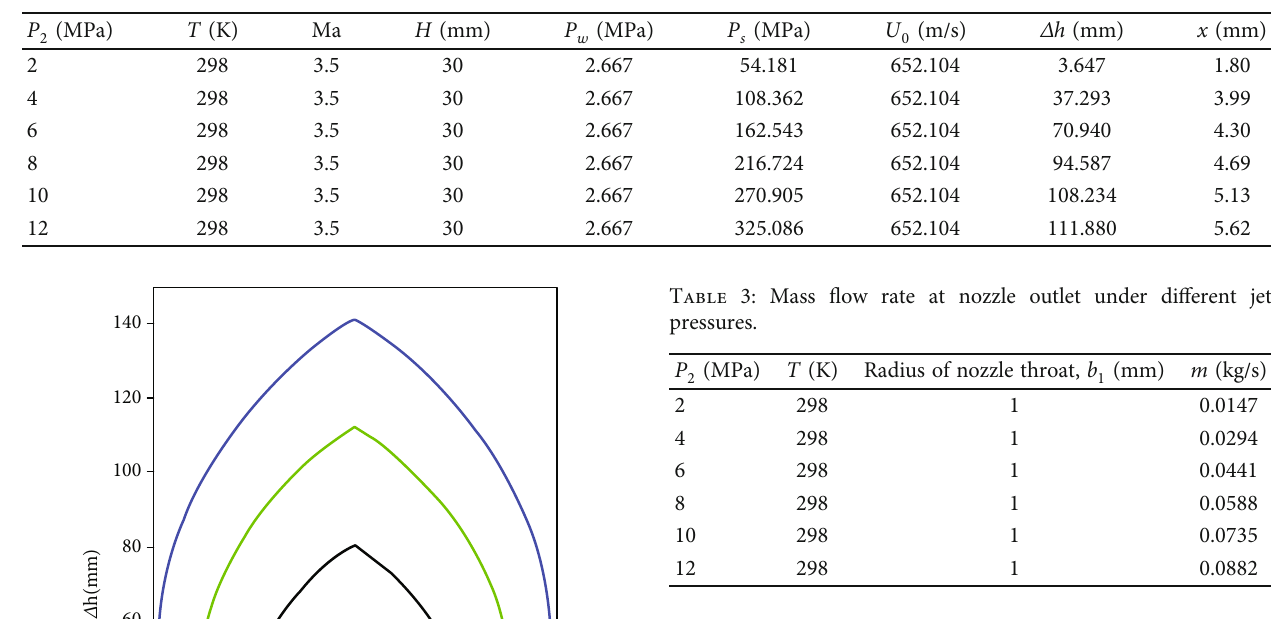
Table 1: The theoretical values of the parameters under di ff erent jet pressures.